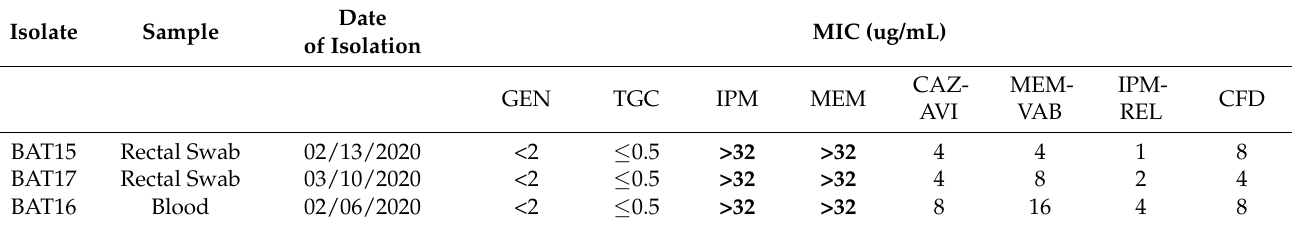
Table 1. Phenotypic characteristics of KPC-Kp strains included in this